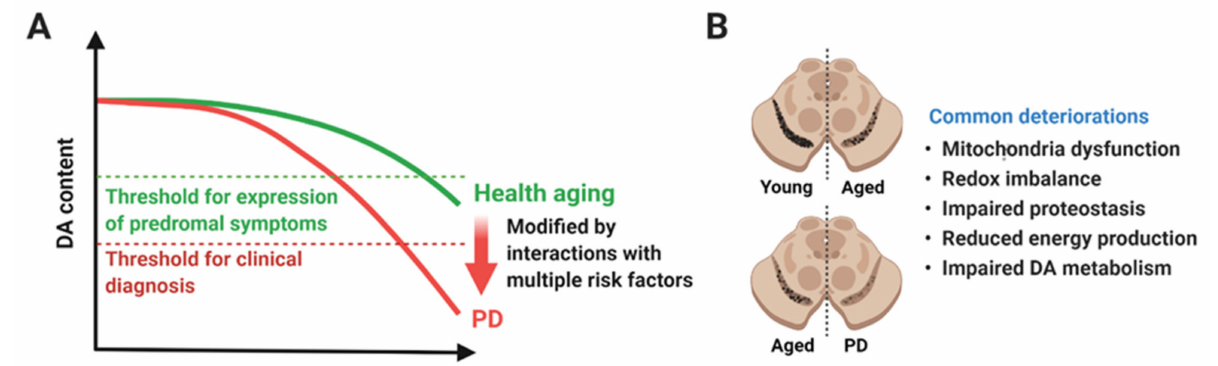
Figure 1. A hypothetical model of aging and Parkinson’s disease (PD). ( A ) Functional DA neurons are reduced in both healthy aging and PD. Rate of degeneration in healthy aging and PD might be similar up to a certain time point or age, but degeneration in PD is accelerated until reaching the threshold for clinical diagnosis (red dotted line). The upper green dotted line represents the threshold for expression of prodromal symptoms. Several genetic and environmental risk factors might play a role in accelerating degeneration of DA neurons and causing PD. ( B ) Degeneration of DA neurons in the SN is considered as the pathological hallmark of PD, but it also occurs in healthy aging. The difference in healthy aging and PD might be the quantity of neurodegeneration rather than the quality. Healthy aging and PD share a plethora of cellular dysfunctions, such as mitochondrial dysfunction, redox imbalance, impaired proteostasis, reduced energy production, and impaired DA metabolism. Created with